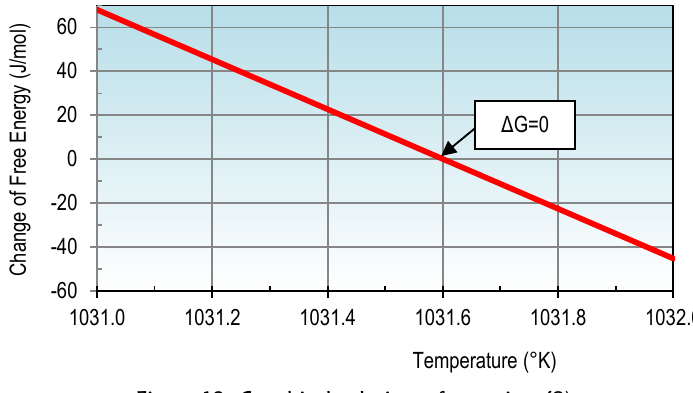
Figure 10: Graphical solution of equation